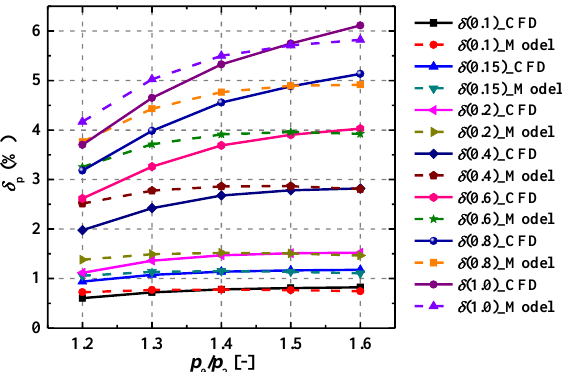
Figure 22. Variation of the attenuation magnitude of the reflected shock pressure ratio with the ideal shock strength.